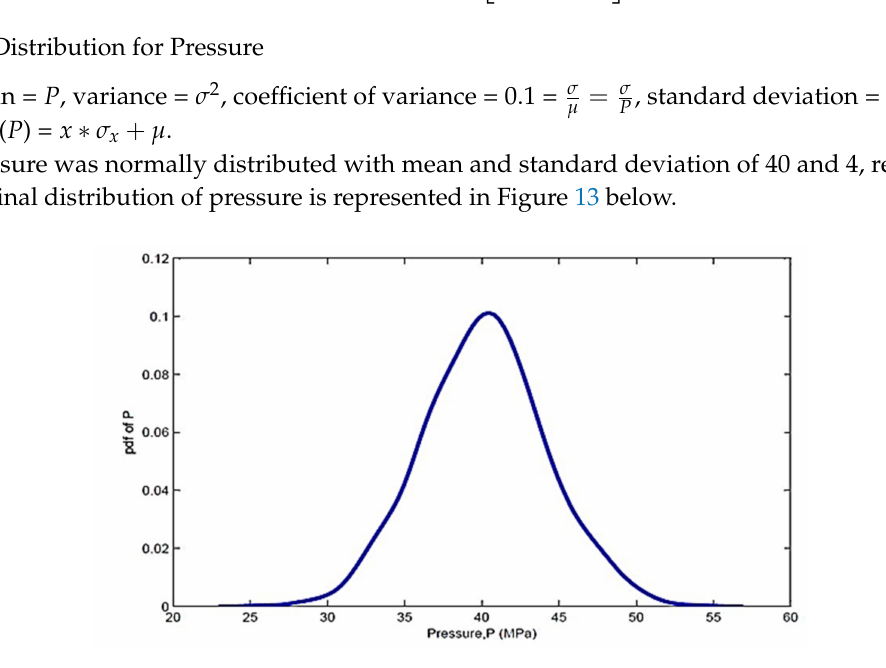
Figure 13. Nominal distribution of